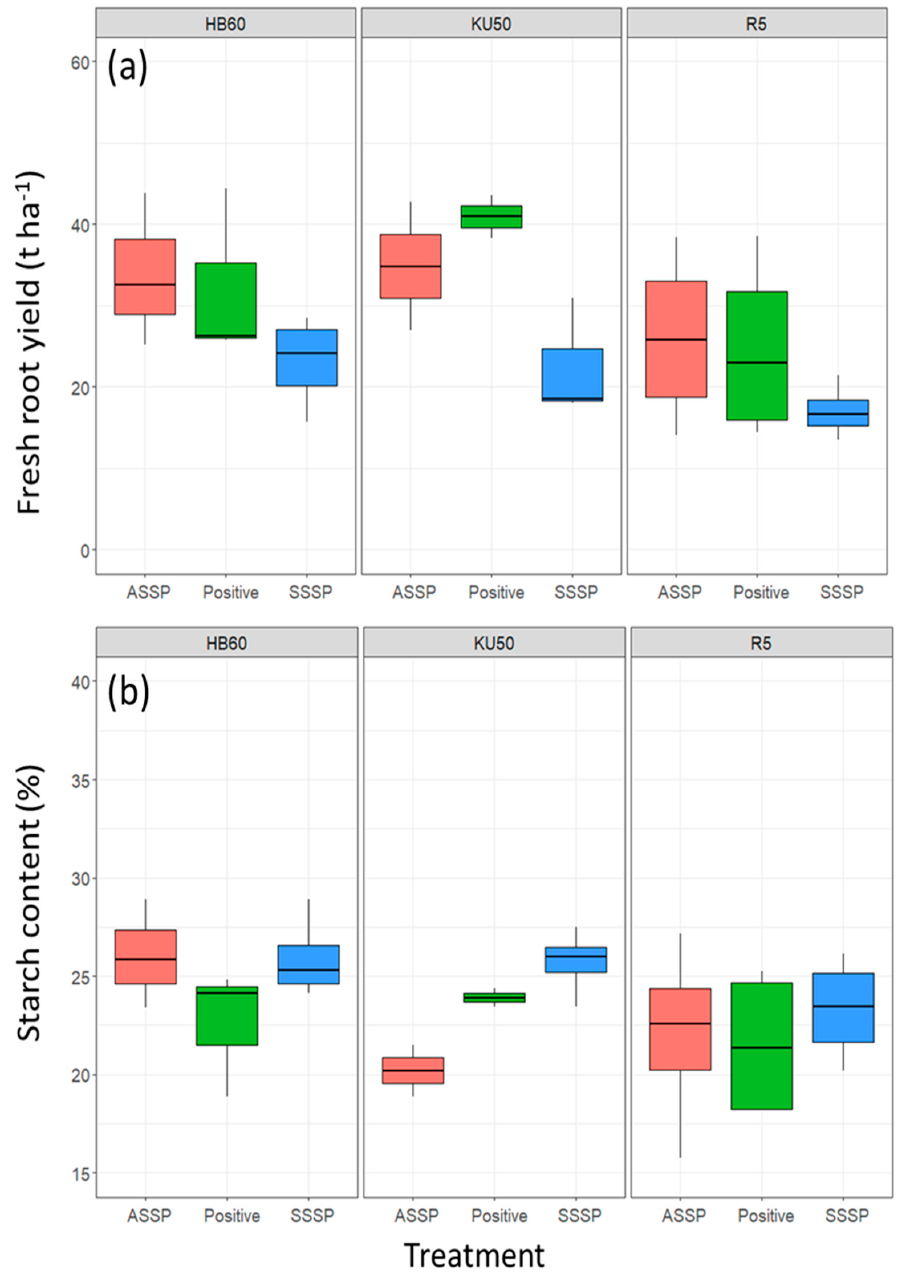
Figure 4. Fresh root yield (t ha − 1 ) ( a ) and starch content (%) ( b ) of three cassava varieties planted with three planting material classes: positive selection, asymptomatic stems from symptomatic plants (ASSP) and symptomatic stems from symptomatic plants (SSSP).